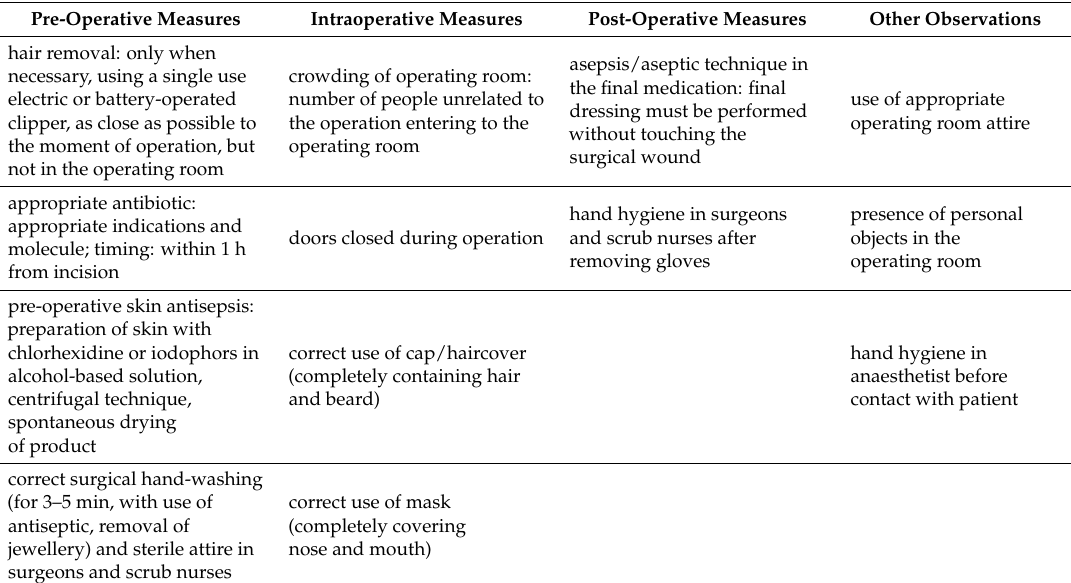
Table 1. Infection prevention measures undertaken to